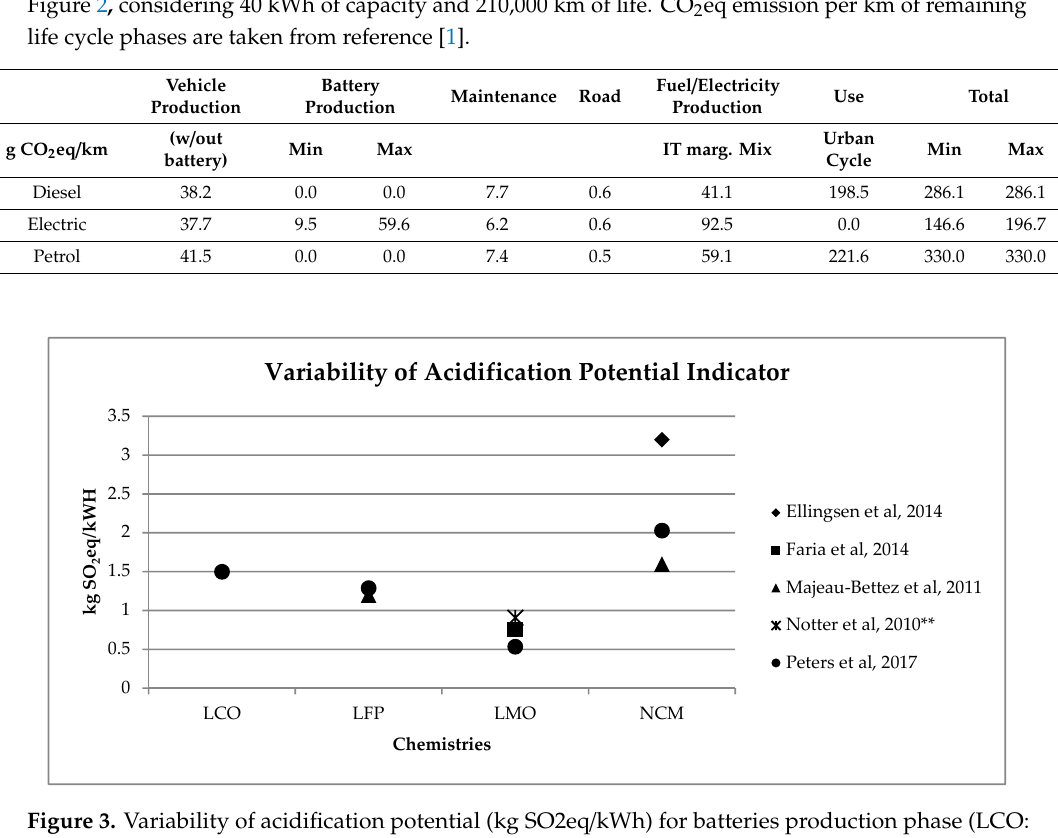
Figure 3. Variability of acidification potential (kg SO2eq/kWh) for batteries production phase (LCO: Lithium Cobalt Oxide; LFP: Lithium iron phosphate; LMO: Lithium Manganese Oxide; NCM: Lithium Nickel Cobalt Manganese Oxide); ** data from reference [11] have been updated using Ecoinvent v 3.5.